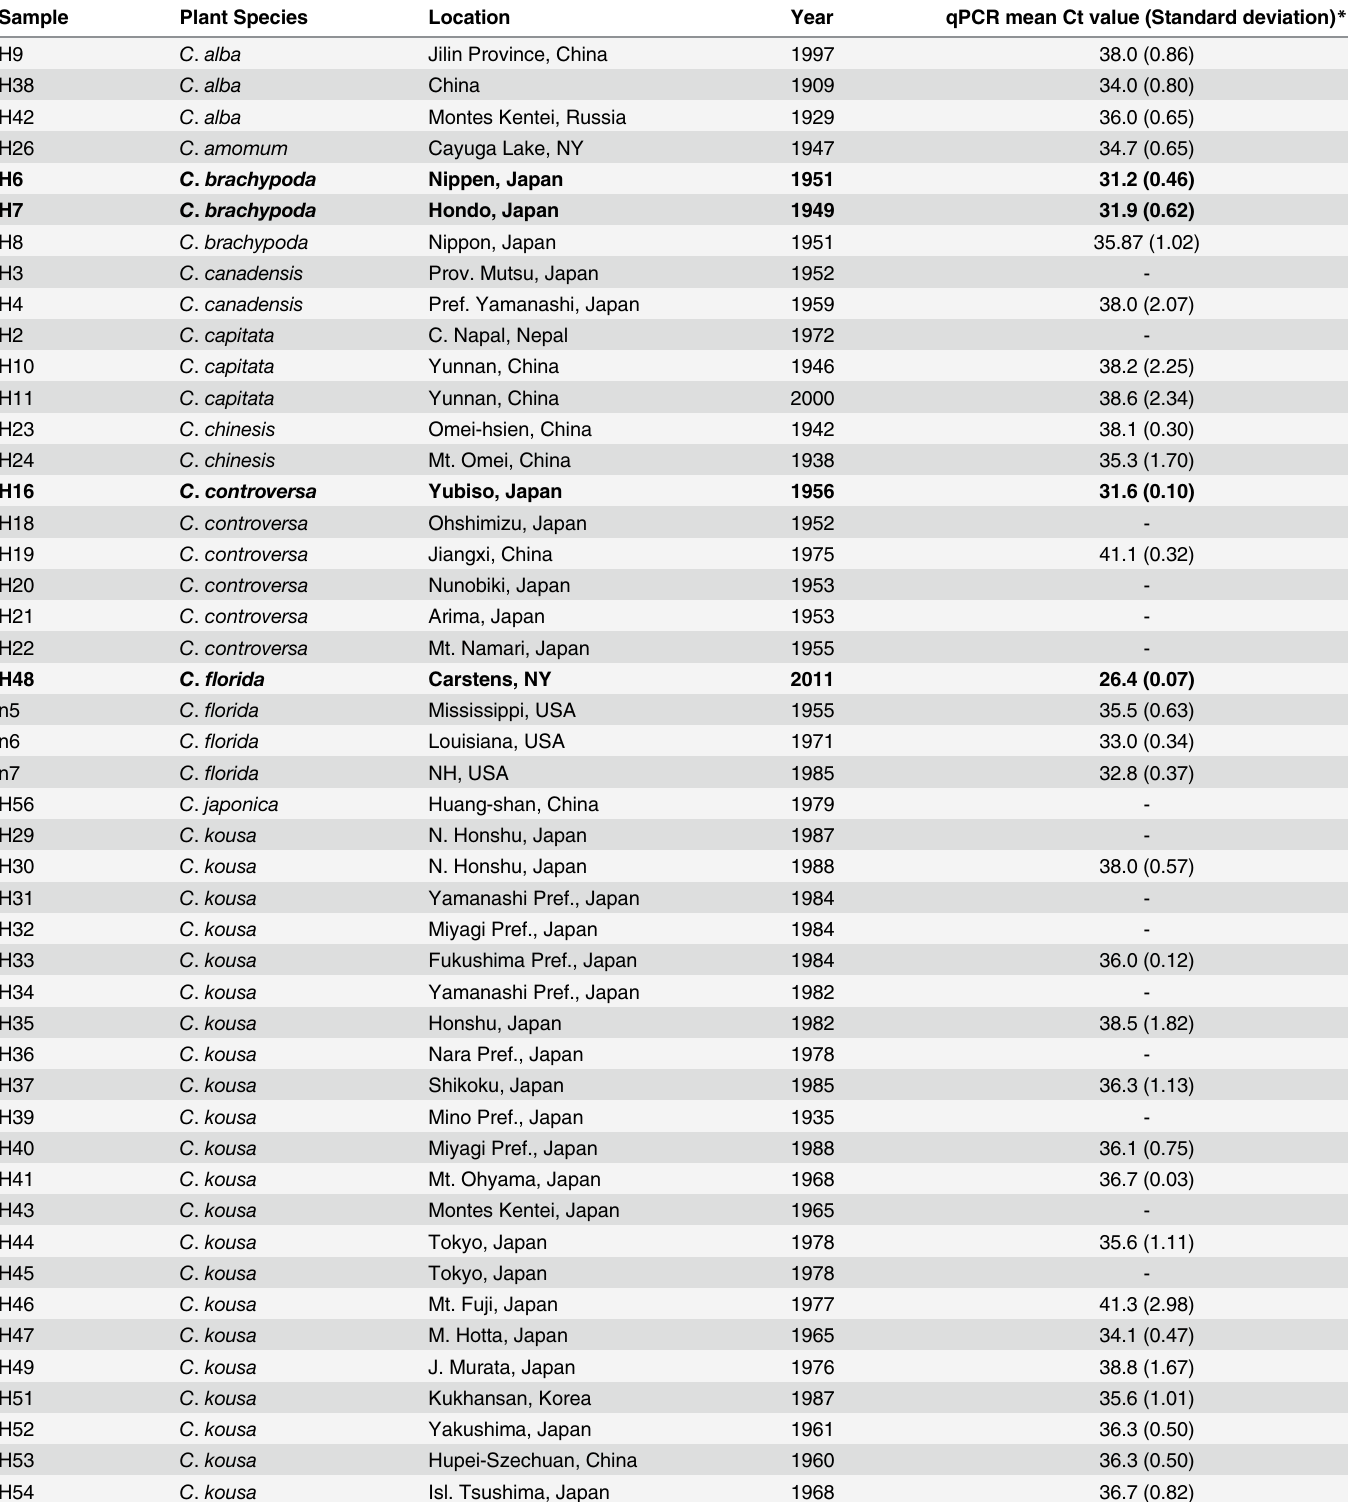
Table 1. Real-time PCR results of Cornus herbarium samples with species name, location, and year of collection.